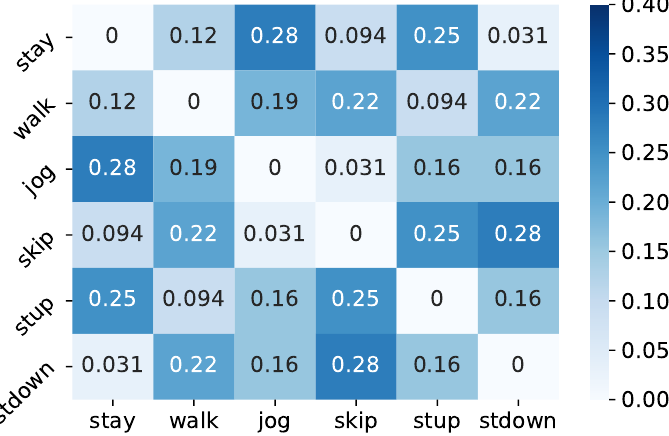
Figure 7. Percentage of two classes merged in Level 2 of the lower 1% class hierarchy.